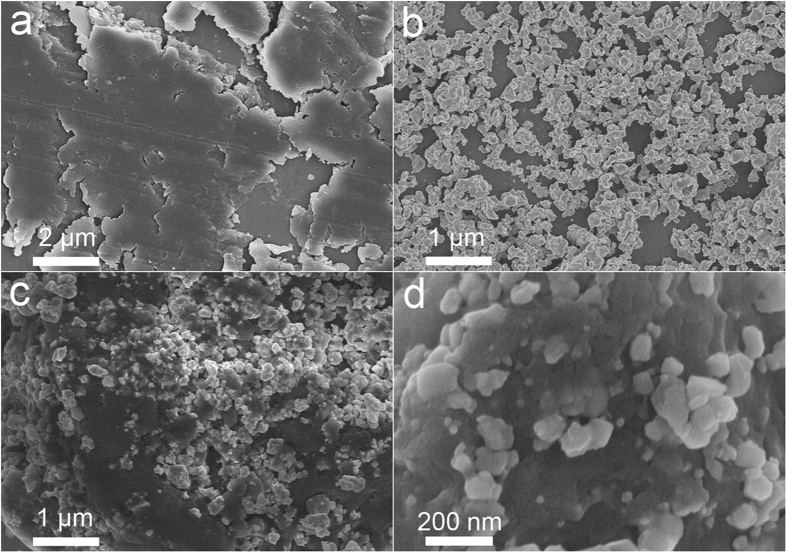
FE-SEM images of (a) g-C3N4, (b) LaNiO3, (c) 10 wt.% CNL and (d) magnified images of 10 wt.% CNL hybrid catalyst.